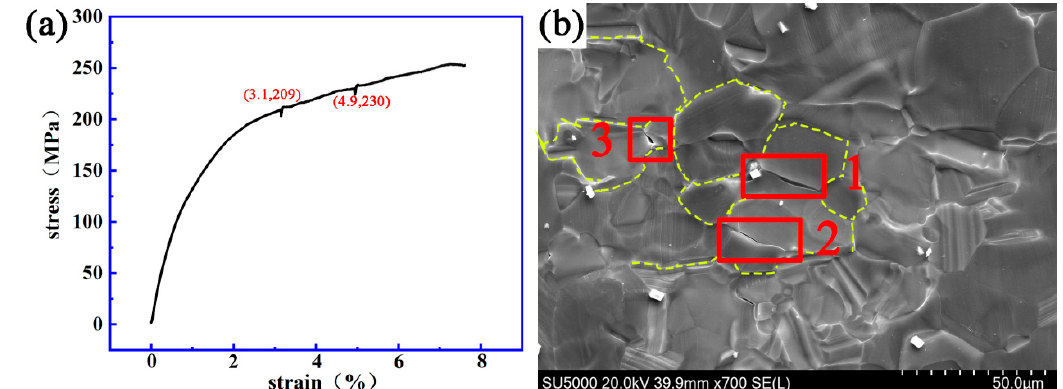
Figure 9. The dynamic change process of crack initiating and extending a Mg-13Gd-5Y-3Zn-0.3Zr alloy after solution treatment at 510 °C for 19 h. ( a ) The stress–strain curve. ( b ) The evolution process of the micro-crack.